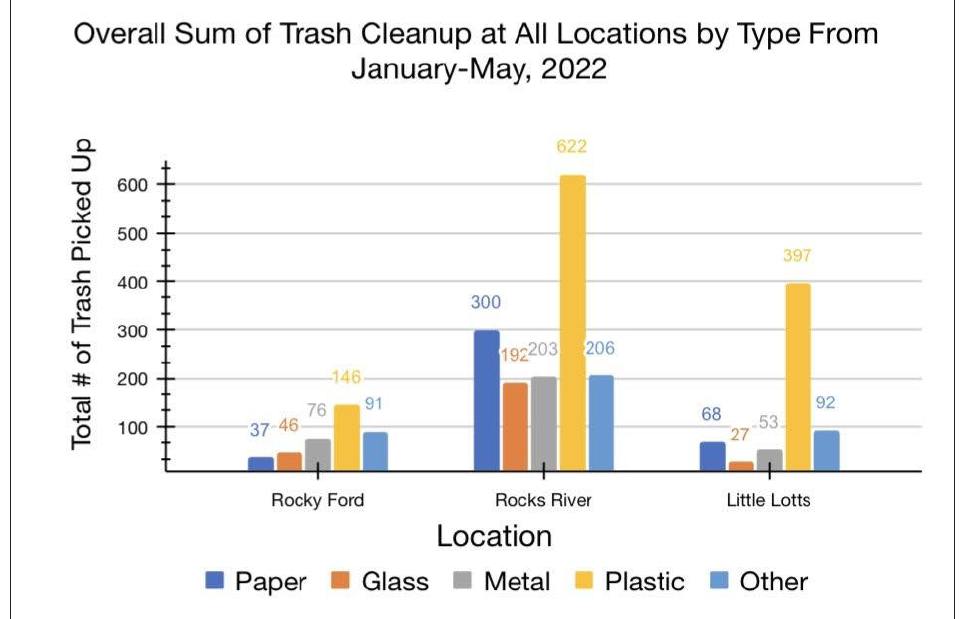
Figure 13. Trash Analysis — Total Overall Count of Trash Picked Up by Type per Location.